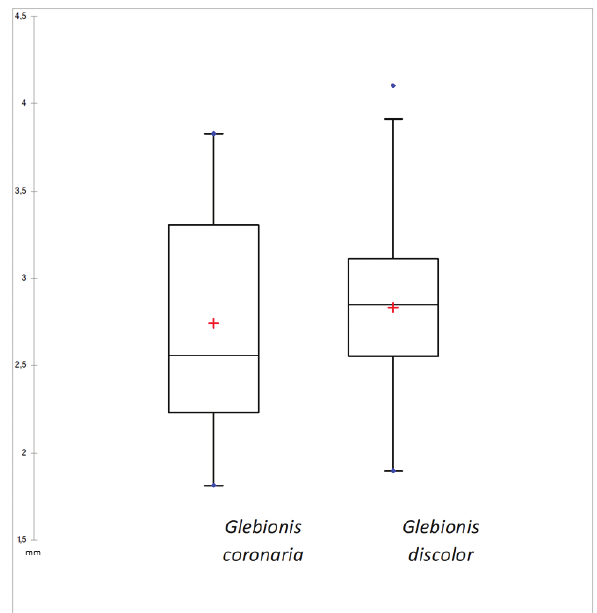
Figure 7. Statistical analysis by box plot of disc cypselas length of Glebionis coronaria and G. discolor .